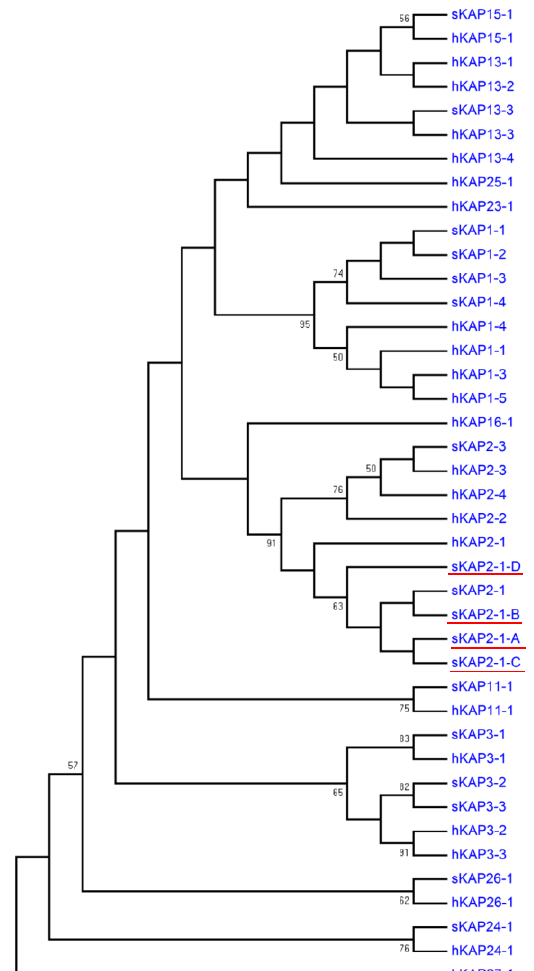
Figure 3. Phylogenetic tree of high-sulfur keratin-associated proteins identified in sheep and humans. The tree was constructed using amino acid sequences. The numbers at the forks represent the bootstrap confidence values and only those equal to or higher than 50% are shown. The sheep sequences are indicated with “s” and those from humans with “h”. The four newly identified sheep keratin-associated protein 2-1 sequences are indicated with red horizontal lines. The GenBank accession numbers for other high-sulfur keratin-associated proteins are X01610 (sKAP1-1 and sKAP1-4), NM_030967.2 (hKAP1-1), HQ897973 (sKAP1-2), X02925 (sKAP1-3), NM_030966.1 (hKAP1-3),